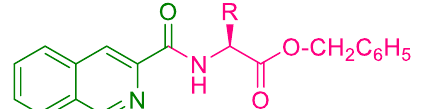
Figure 38. Benzyl esters of N-isoquinoline-3-carbonyl- L -leucine and N-isoquinoline-3-carbonyl- L -threonine.